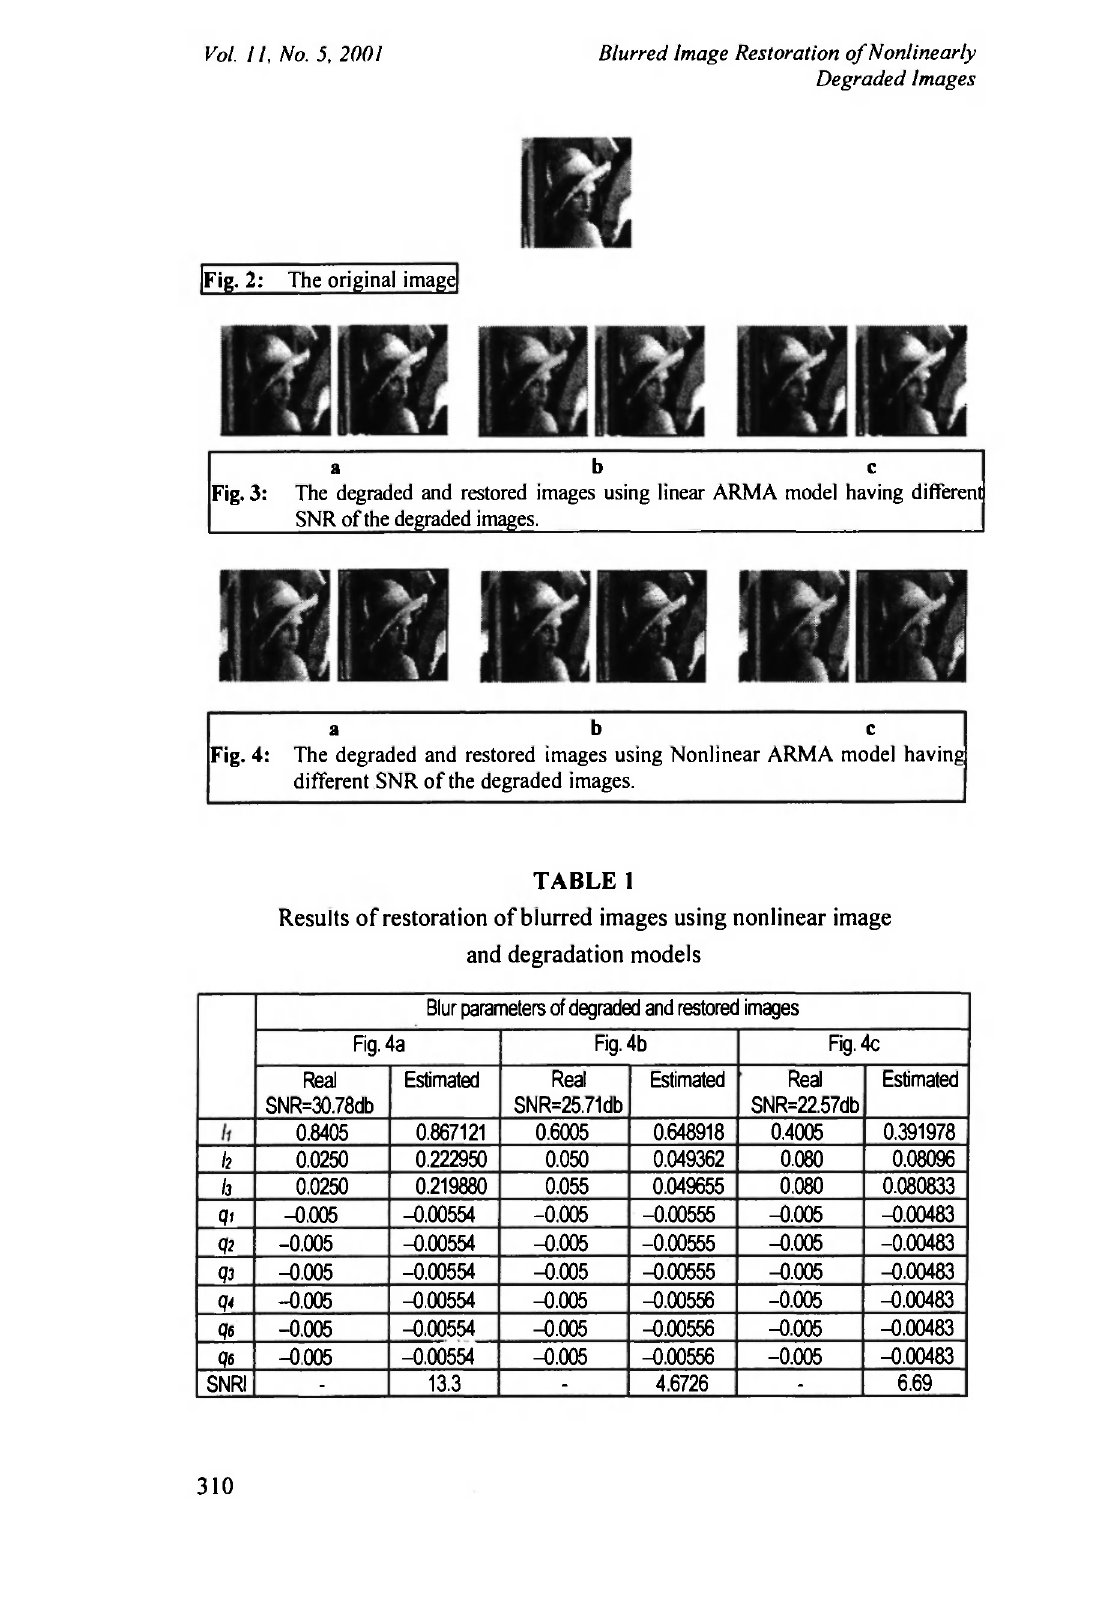
Fig. 3: The degraded and restored images using linear ARMA model having different SNR of the degraded images.